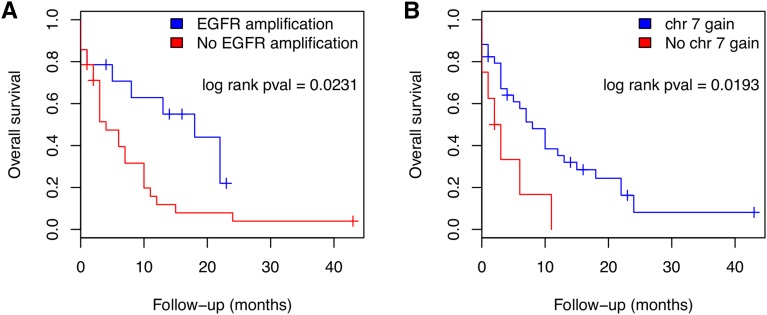
Survival curves of the patients considering (A) EGFR amplification and (B) chromosome 7 gain.